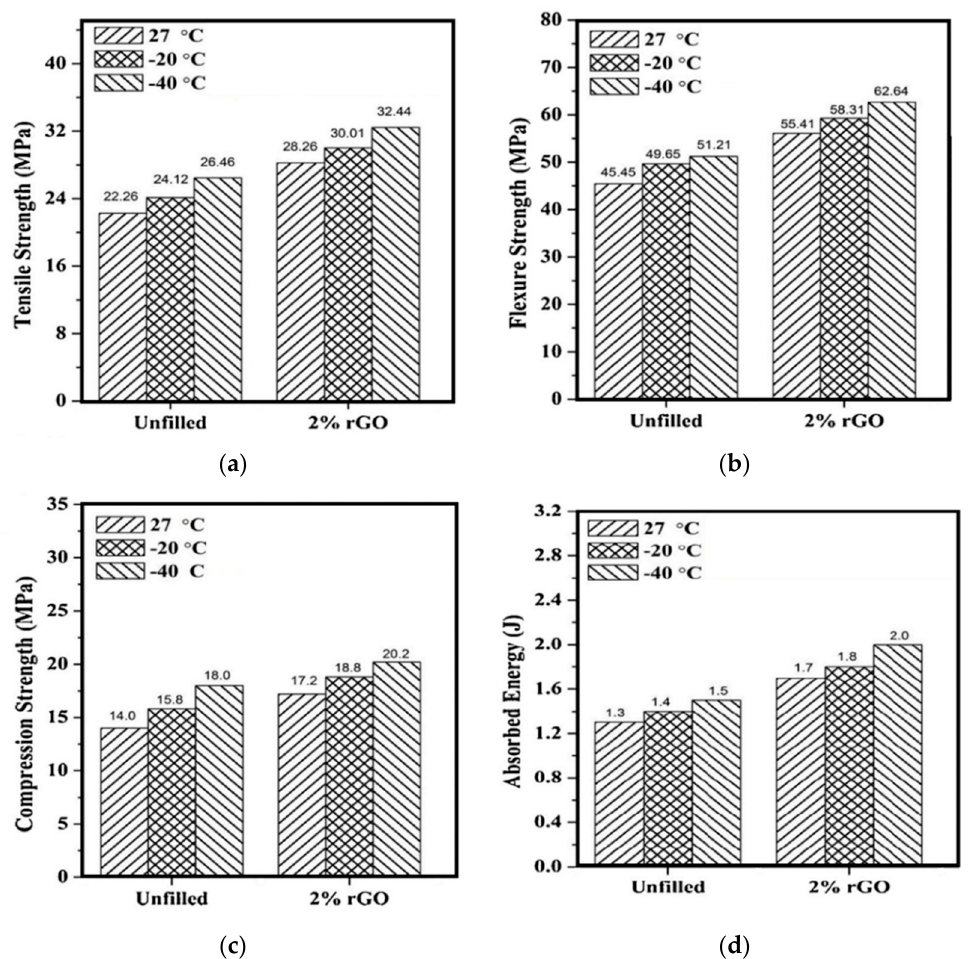
Figure 5. Properties of jute/epoxy composites incorporated and non-incorporated with rGO: ( a ) tensile, ( b ) flexural, ( c ) compression, and ( d ) Izod impact resistance. Adapted from [49].